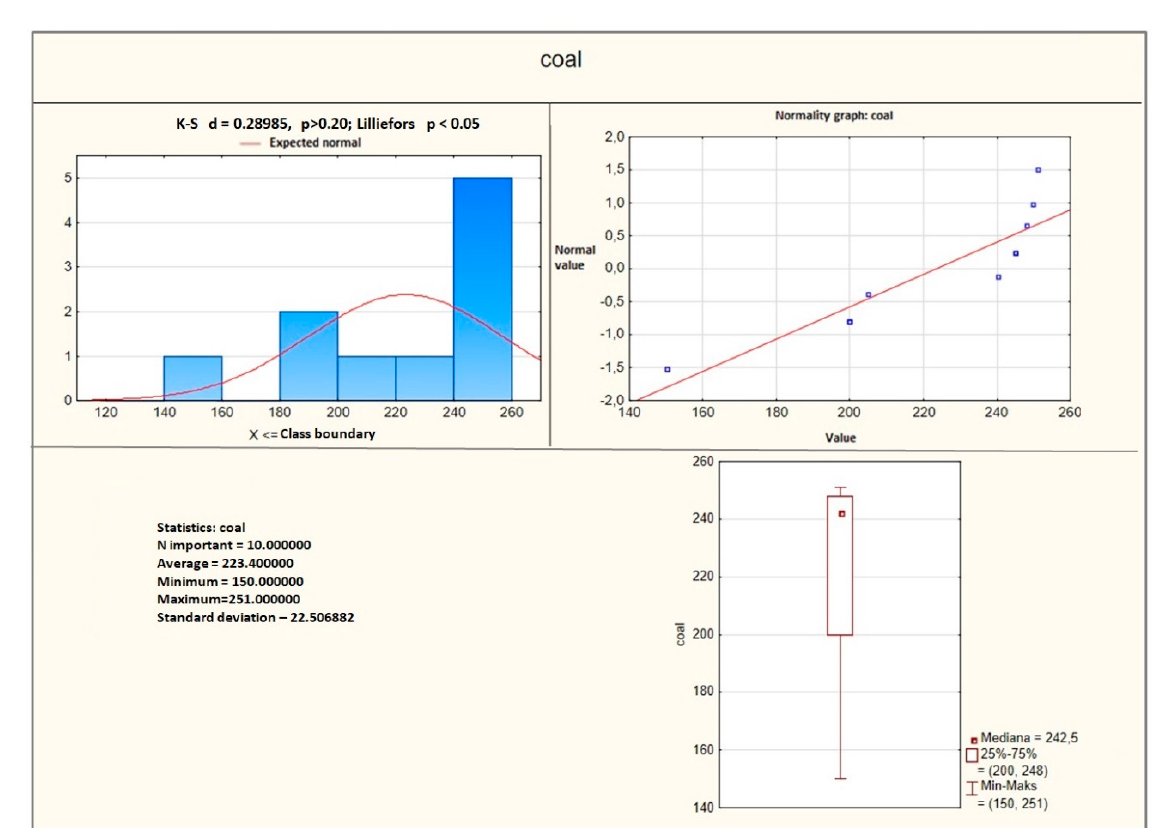
Figure 33. Statistical calculations for lignite.